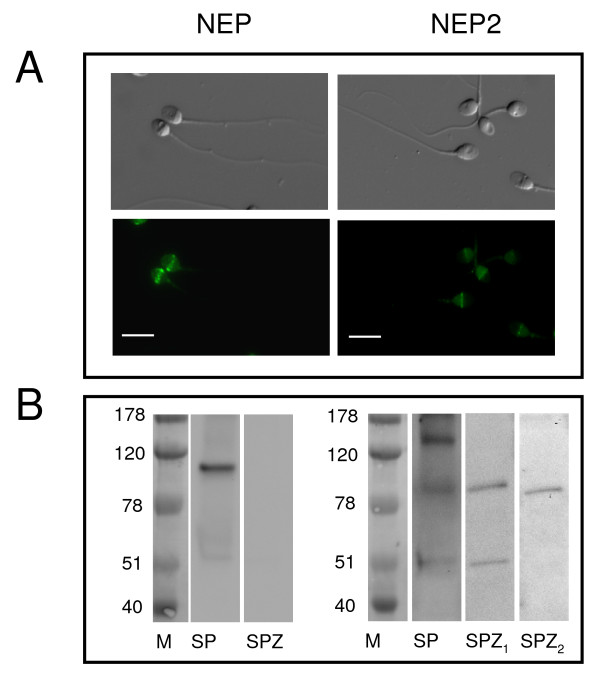
Localization of neprilysins in human sperm. (A) Immunofluorescence and corresponding differential interference contrast images of sperm cells stained with primary antibodies against neprilysin (NEP) and neprilysin-2 (NEP2). Experiments were performed at least six times with similar results. Scale bar, 10 μM. (B) Western Blot analysis of NEP and NEP2 in human spermatozoa (SPZ) and seminal plasma (SP) homogenates. For NEP2, SP and SPZ1 represent results obtained with the NEP2 antibody sc-104450 and SPZ2 represents results obtained with the NEP2 antibody HPA 007876 (see text for further details). Results are representative of at least five separate protein preparations, each from eight different donors.